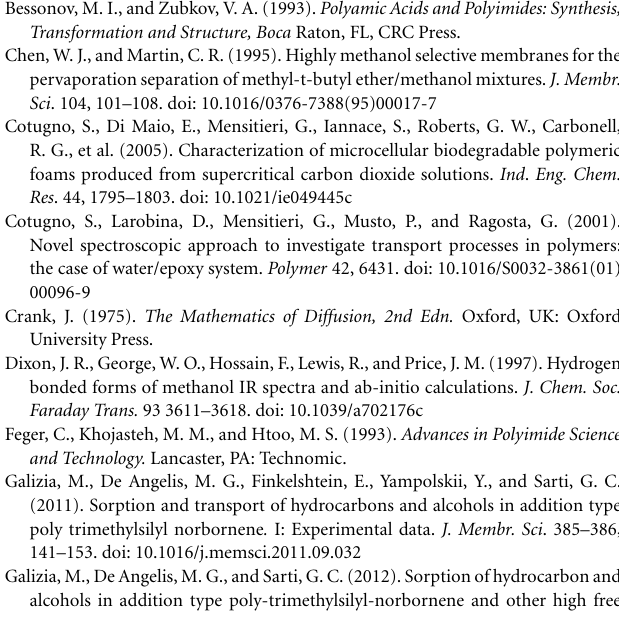
whole range of concentrations encompassed in the diffusion process,